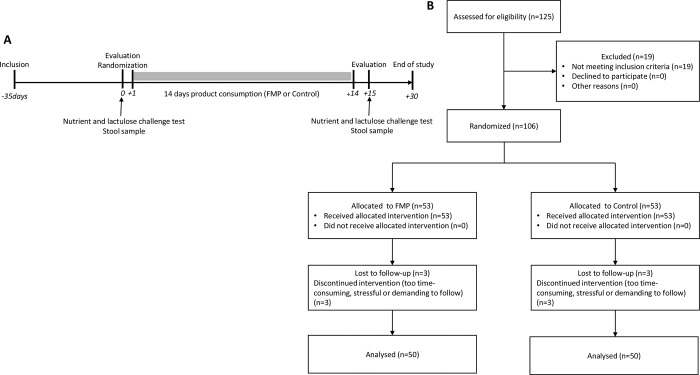
A) Study design B) Flow chart demonstrating the number of patients in the different phases of the study.